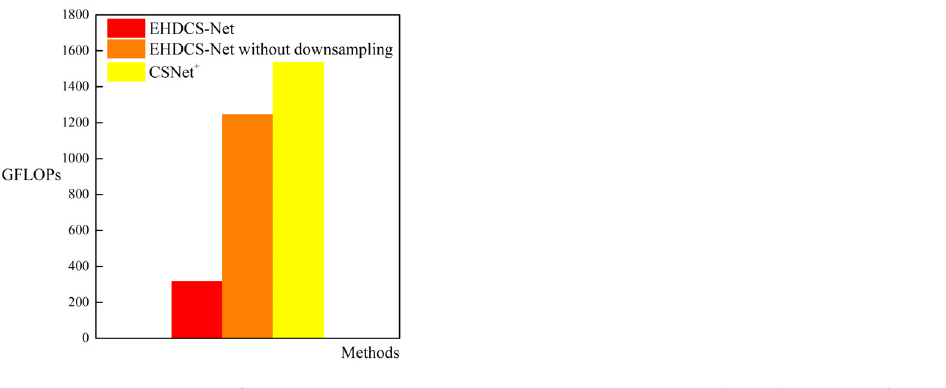
Figure 9. Comparison of GFLOPs among EHDCS-Net, EHDCS-Net without downsampling, and